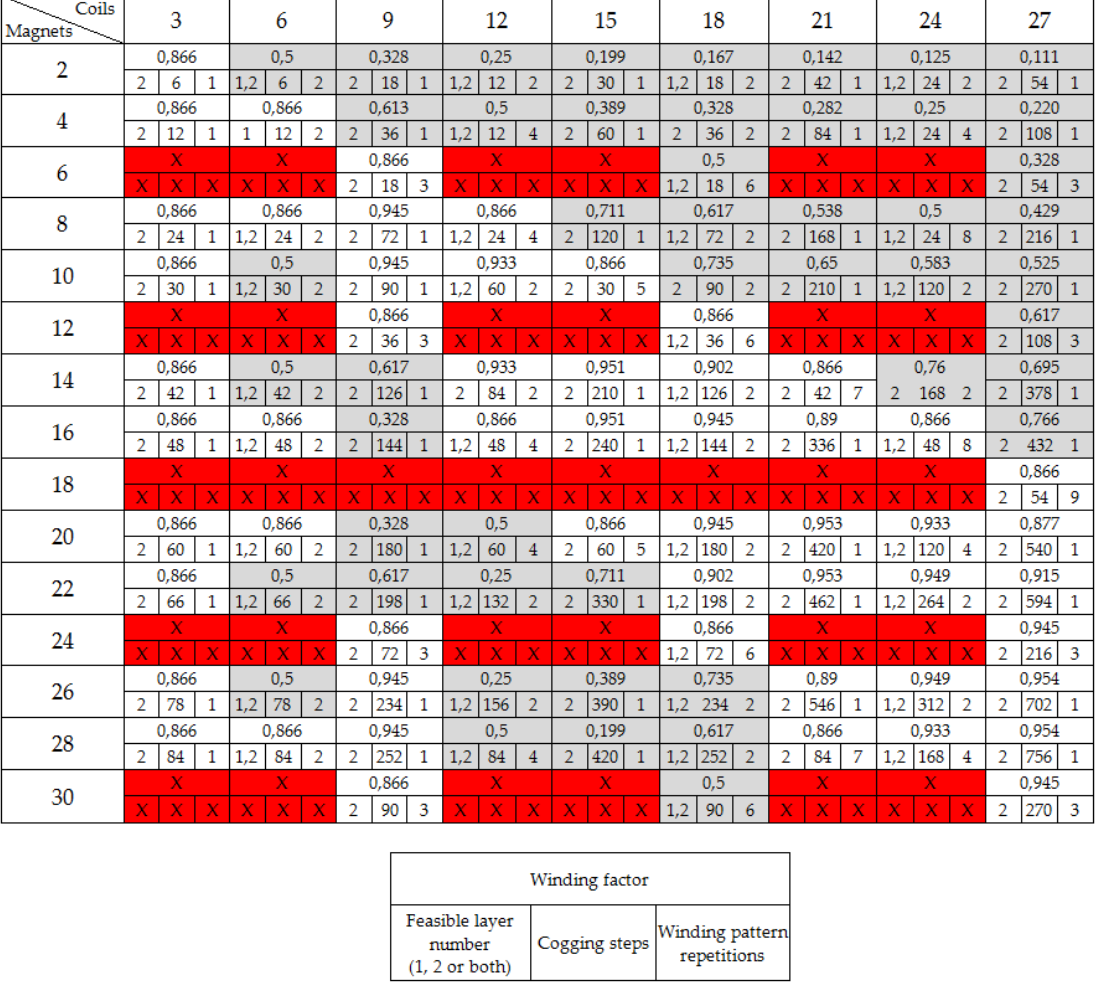
Figure 4. Value of winding factor k W in relation to the combination of number of concentrated winding and number of magnets on the rotor.